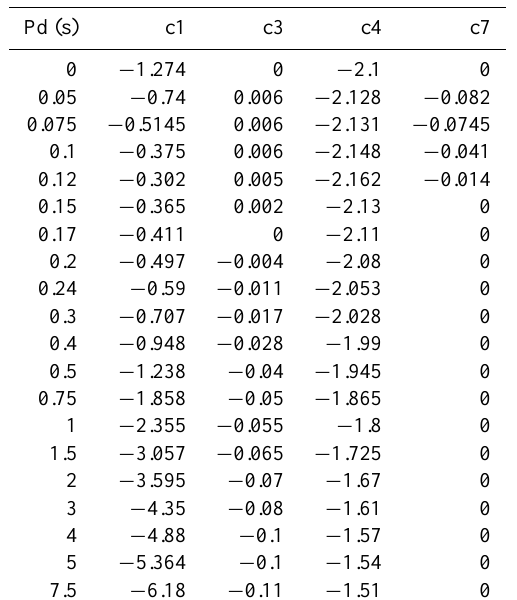
Table 5. Coefficients of the horizontal response spectral accelera- tions (5% damping) for rock sites.